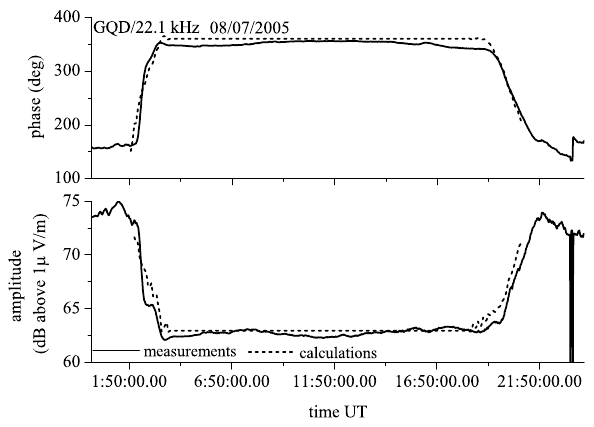
Fig. 1. Diurnal variations of the GQD signal phase (upper panel) and amplitude (lower panel), on 8 July 2005. AbsPAL recordings – solid lines; LWPC simulation – short dashed